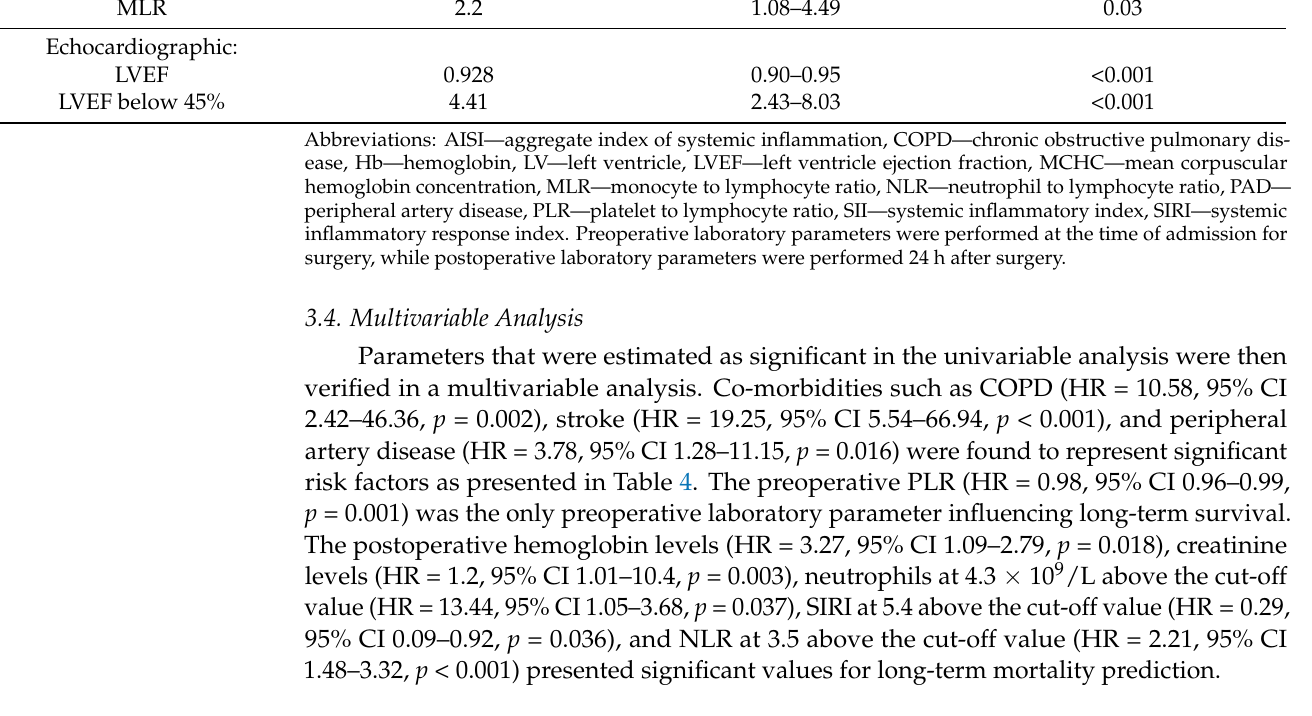
Table 4. Multivariable Cox regression model